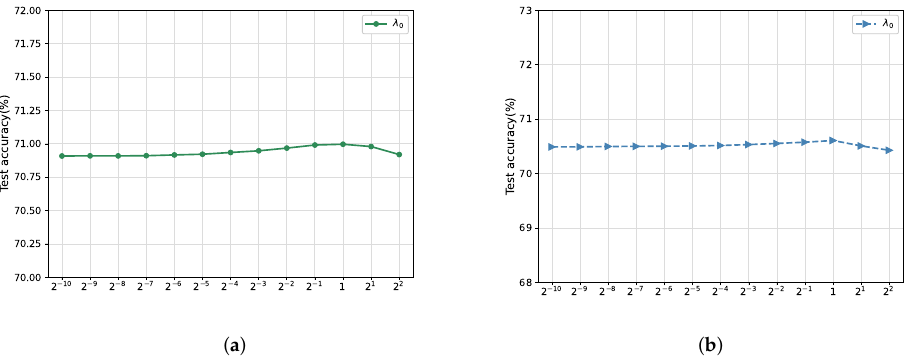
Figure 7. Influences of parameters λ 0 . ( a ) shows experimental results on NWPU-RESISC45, and ( b ) shows experimental results on RSD46-WHU.